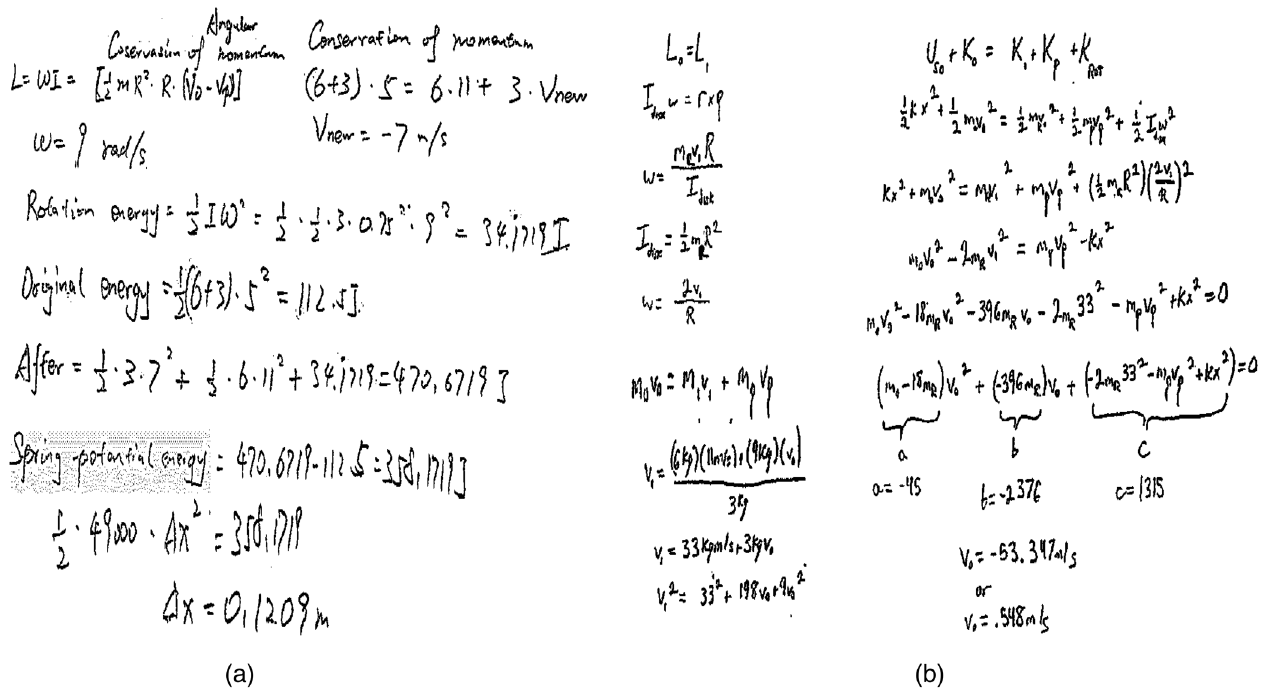
FIG. 13. Written solutions of those students combining the formulated equations and simplifying the combined equations for the (a) simple, and (b) complex simultaneous synthesis